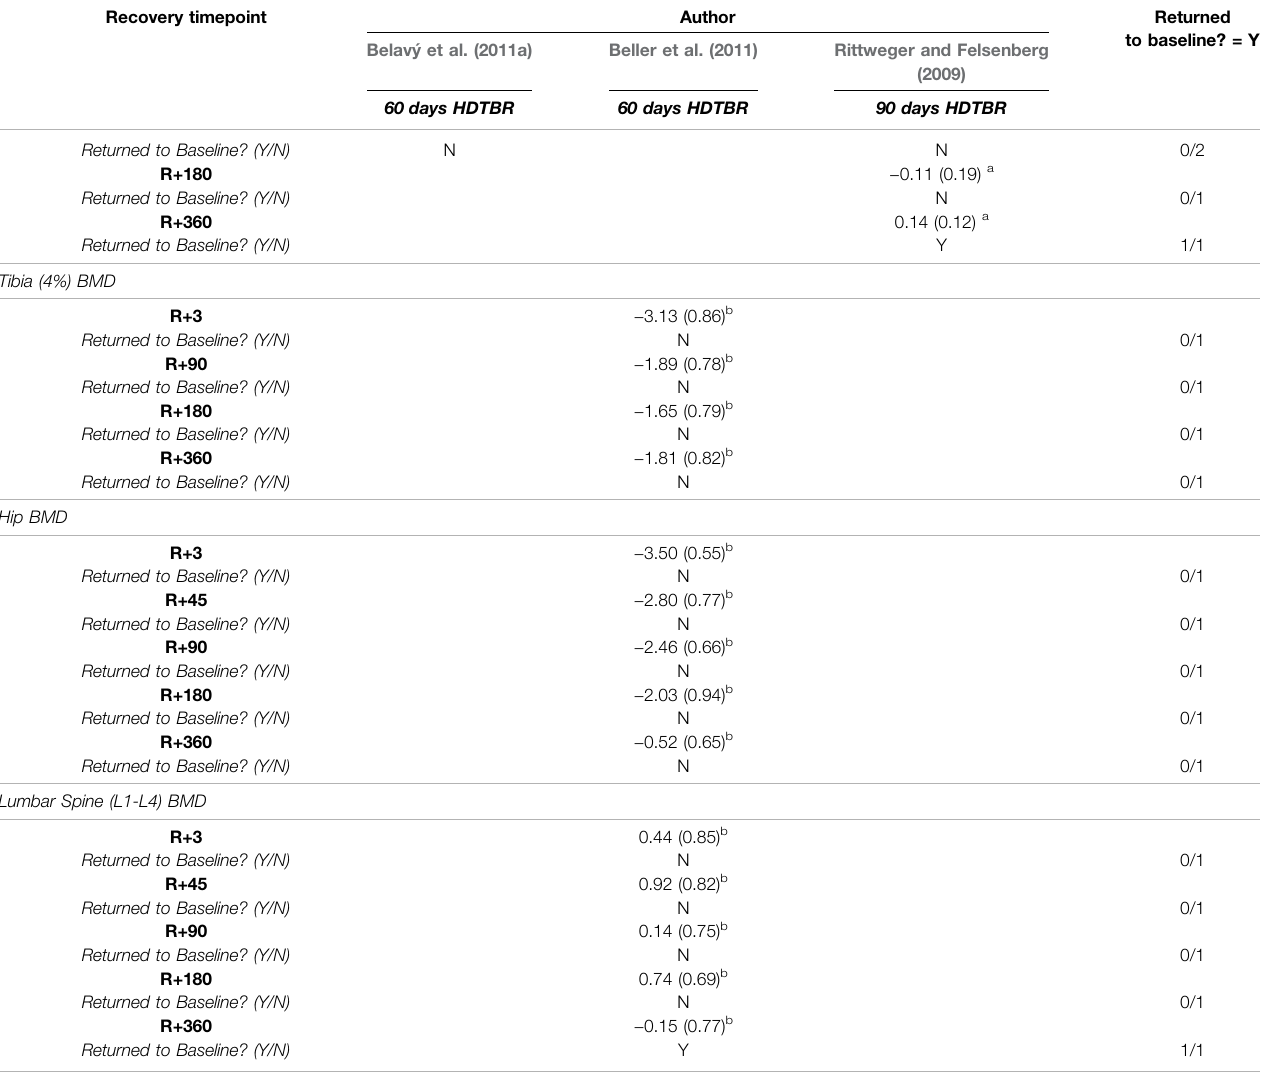
TABLE 4 | ( Continued ) % Change with SD of outcome parameters related to the ‘ Skeletal System ’